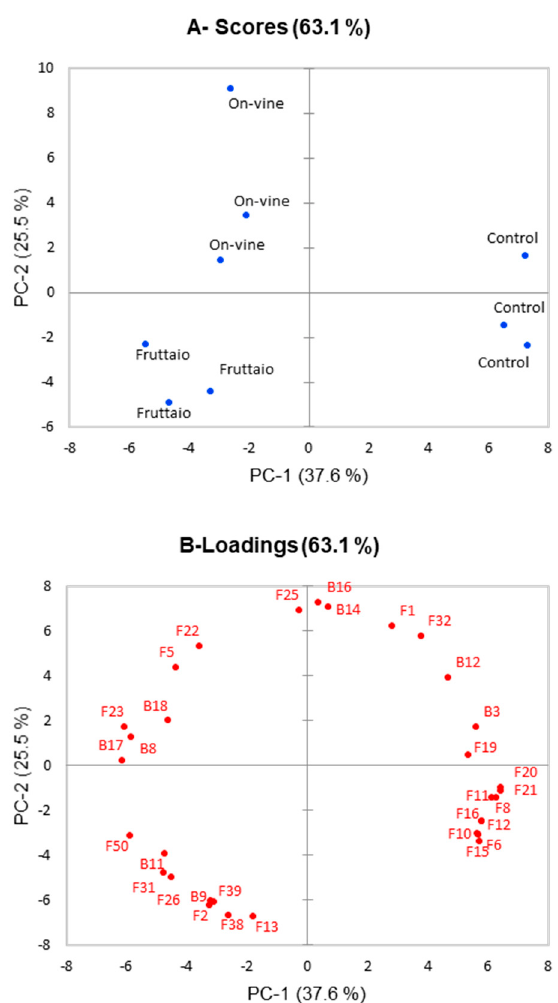
Figure 2. Principal component analysis showing aged wine samples scores ( A ) and loadings ( B ), only loadings with score value > 0.75 were shown. Loadings plot number correspond to: (F1) 2-Butanol, (F2) 1-Butanol, (F5) Phenyl ethyl alcohol, (F6) 1-Hexanol, (F8) cis -3-Hexenol, (F10) Isoamyl acetate, (F11) n-Hexyl acetate, (F12) Phenylethyl acetate, (F13) Ethyl butanoate, (F15) Ethyl hexanoate, (F16) Ethyl octanoate, (F19) 3-Methylbutanoic acid, (F20) Hexanoic acid, (F21)Octanoic acid, (F22) cis -Linalool oxide, (F23) trans -Linalool oxide, (F25)Terpinen-1-ol, (F26) Terpinen-4-ol, (F31) β -Citronellol, (F32) p-Menthane-1,8-diol, (F38) p-Cymene, (F39) Terpinolene, (F50) Benzyl alcohol, (B3) bound cis -3-Hexenol,